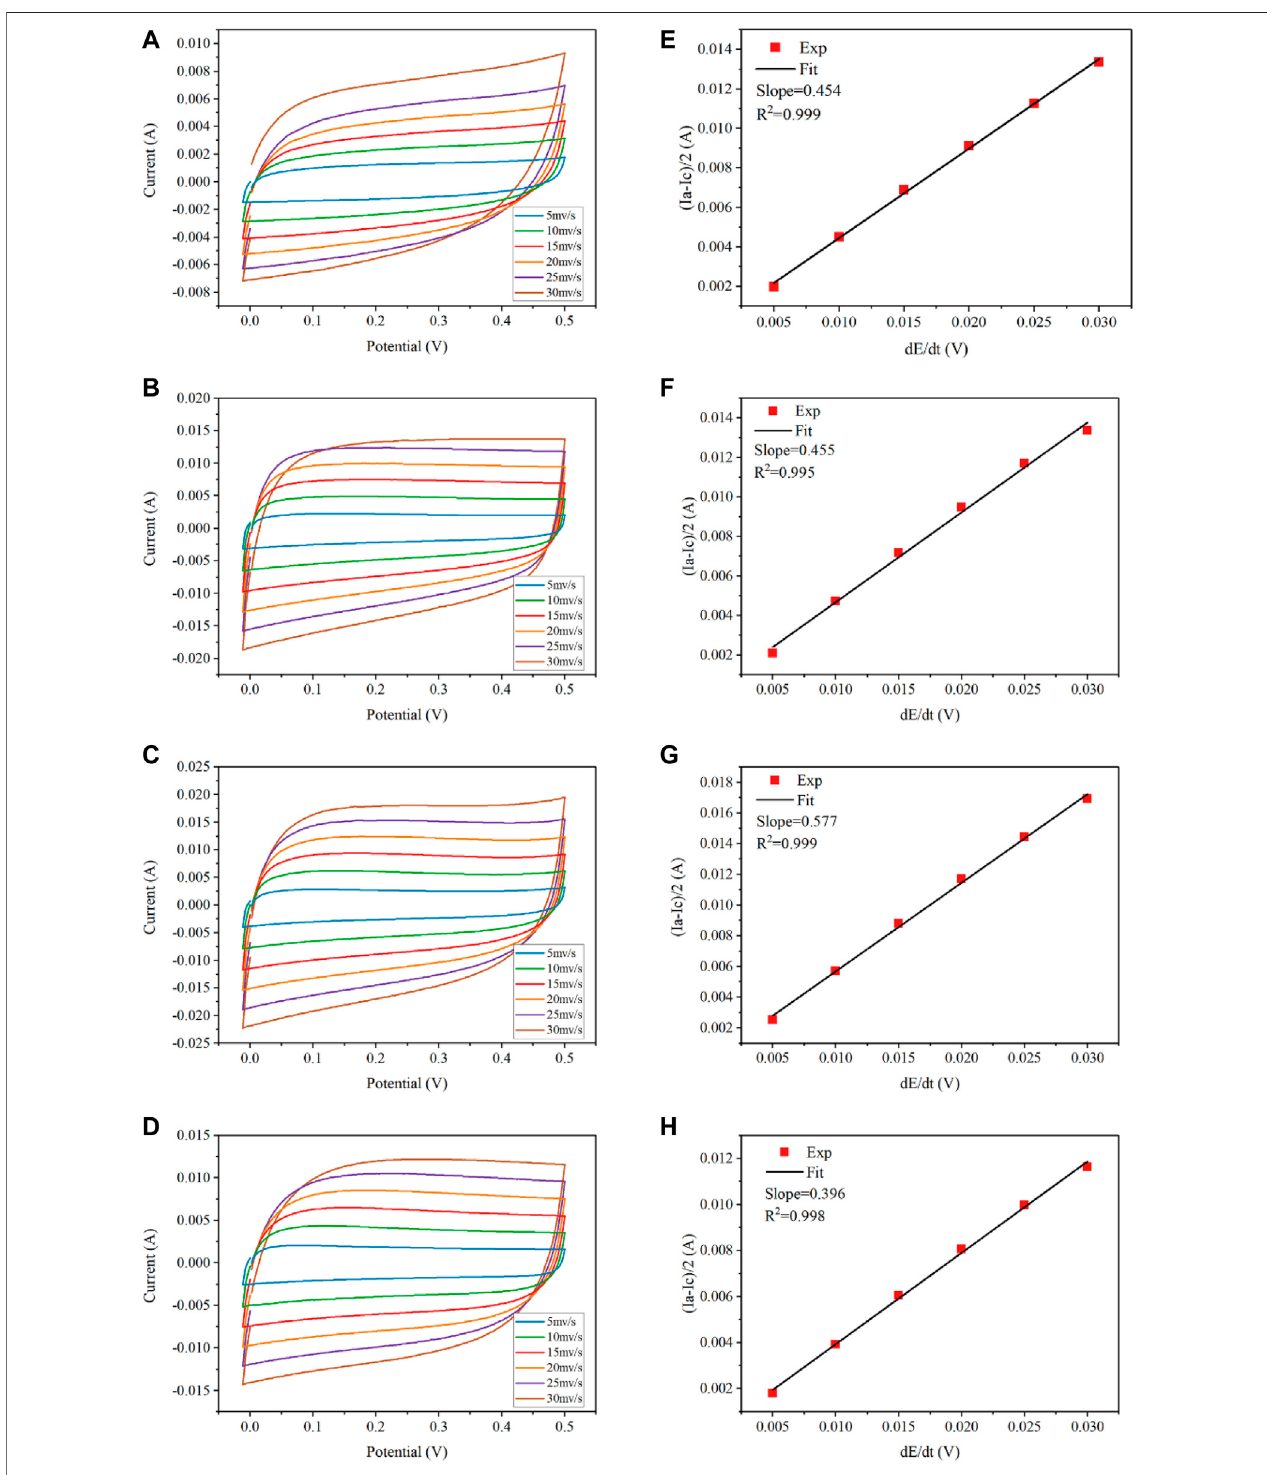
FIGURE 8 | Determination of double-layer capacitance at different scan rates (5 – 30 mV s − 1 ) for REMs using CV in the 100 mM Na 2 SO 4 electrolyte solution. CV scans: (A) 0wt%, (B) 1.5wt%, (C) 5wt%,and (D) 15wt%.Correspondingplotsofchargingcurrentsversusscanrates: (E) 0wt%, (F) 1.5wt%, (G) 5wt%,and (H) 15wt%.